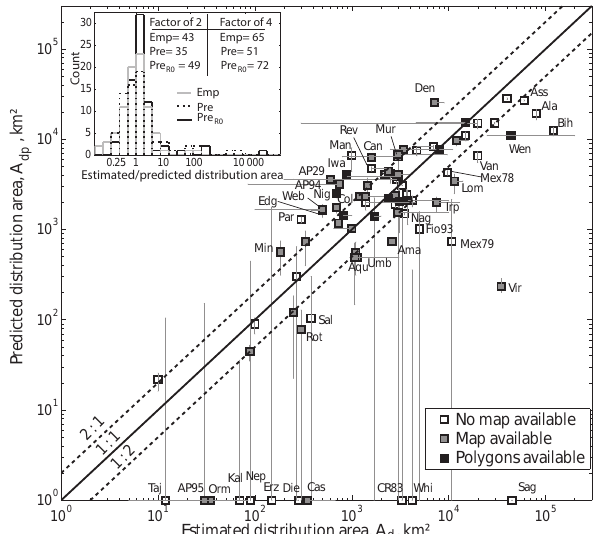
Figure 2. Predicted landslide distribution area plotted against esti- mated landslide distribution areas for 83 earthquakes. For visibility, cases where the predicted area is 0 are set to 1km 2 and only the name codes of earthquakes outside of a factor of 2 from the 1:1 line are shown. Vertical error bars represent the range of predicted values when R 0 is varied between 75 and 125% of the best esti- mate of the hypocentral depth. Inset: histograms of model residuals ( A d /A dp ). Histogram for the best empirical fit of A d against Mo (Emp, grey line) for the model prediction (Pre, dashed line) and for the prediction accounting for 25% of uncertainty on R 0 (Pre R 0 , solid black line) are shown, with the number of earthquakes cor- rectly predicted within a factor of 2 and